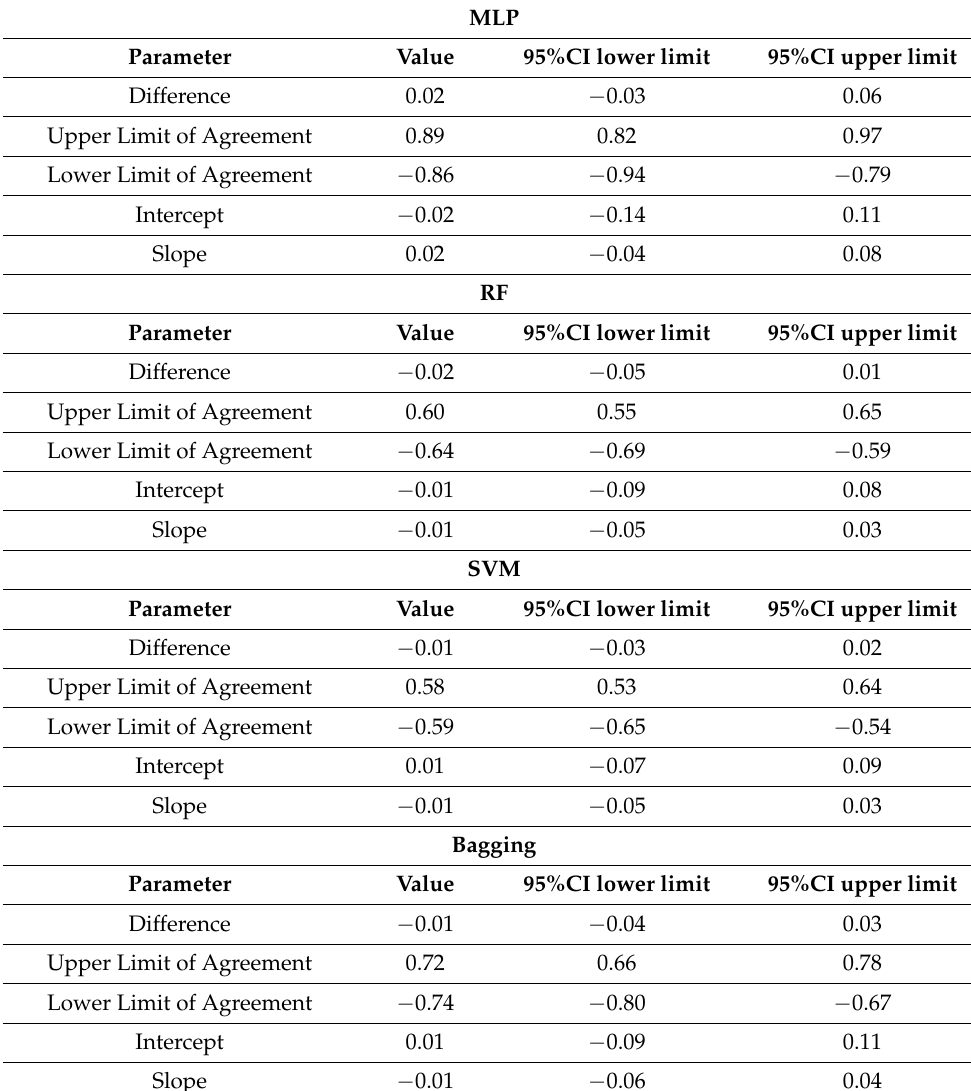
Table 9. Parameters of the Bland–Altman